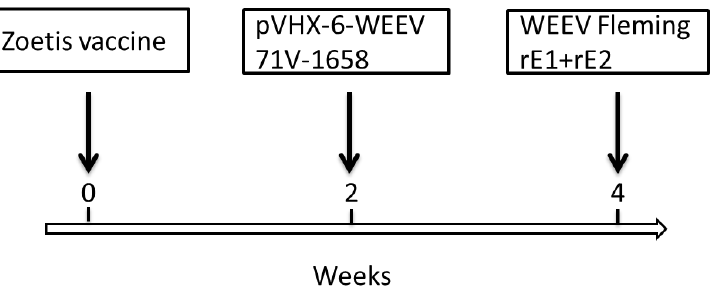
Figure 1. EEEV immunization scheme. Female BALB/c mice were i.m. primed with 100 µL/mouse of Zoetis vaccine at week zero and boosted with 100 µL/mouse of pAd-EEEV PE6 (100 µg) at weeks 2 and 4.